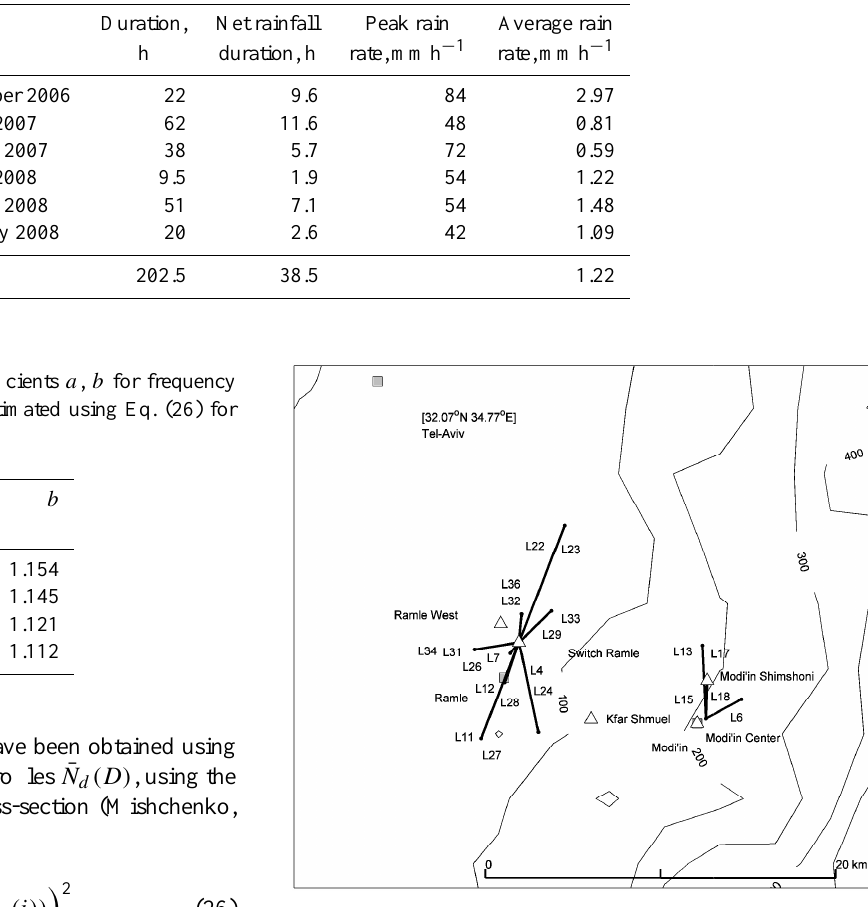
Fig. 2. Locations of microwave links, used for rainfall observations, around the cities of Ramle and Modi’in ( □ ) and rain gauges ( ∆ ) Ramle West, Switch Ramle, Kfar Shmuel, Modi’in Shimshoni and Modi’in Center. The local topography contours are given in meters. The duplicating links installed in parallel are denoted twice, e.g. L22 and L23.